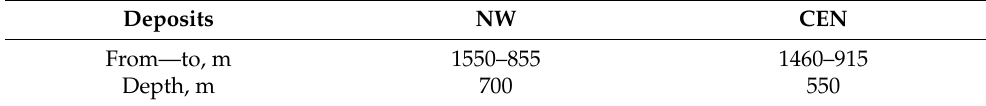
Table 9. The data specification for the 3D